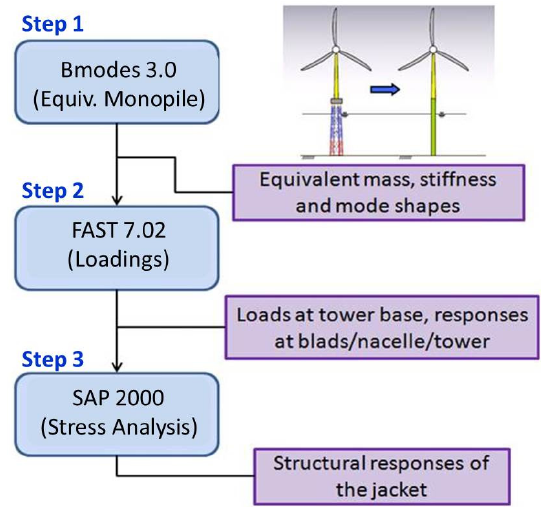
Figure 2. Simplified Flowchart of the Major Analysis Steps for OC4 Jacket Substructure